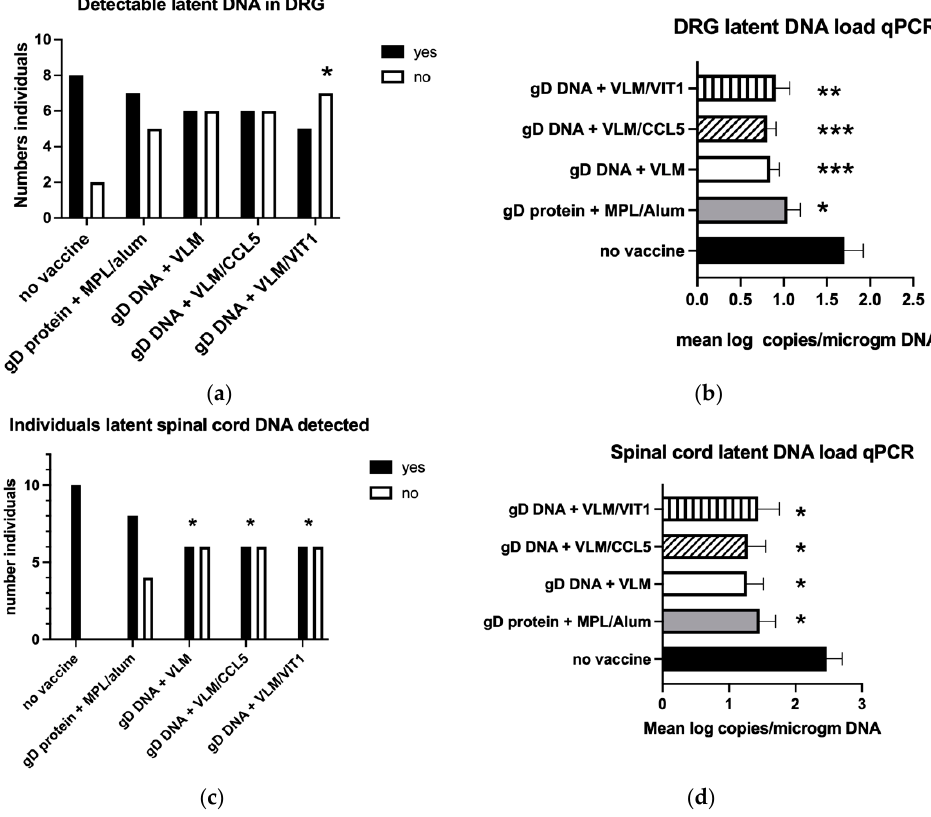
Figure 5. VLM immunisations protect against establishment of latency. Latent DNA was quantified by PCR showing in ( a , c ) detected in DRG or spinal cord, respectively, in individuals as analysed by one tailed chi square, (*) P < 0.05. In ( b , d ) the mean log copies/microgram of DNA measured are compared using one way ANOVA with Tukey’s test for multiple comparisons, (*) P < 0.05, (**) P < 0.01, (***) P < 0.001.